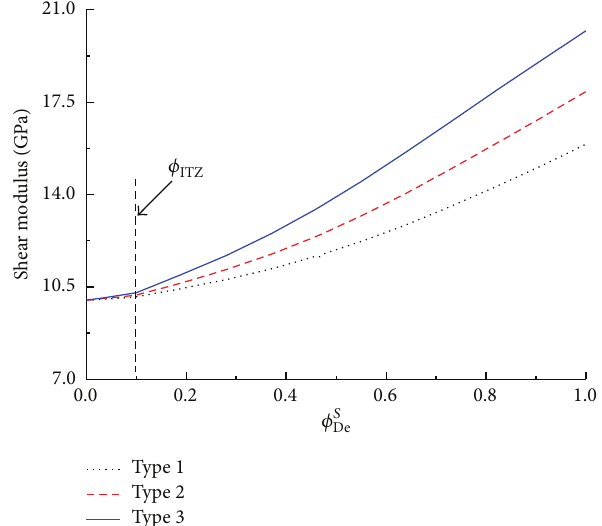
Figure 14: Influence of the properties of the deposition products on the shear modulus of repaired concrete during the healing process, where 𝜙 ITZ is the volume fraction of ITZ in the equivalent particle; 𝜙 𝑆 De is the volume fraction of the deposition products in the equivalent